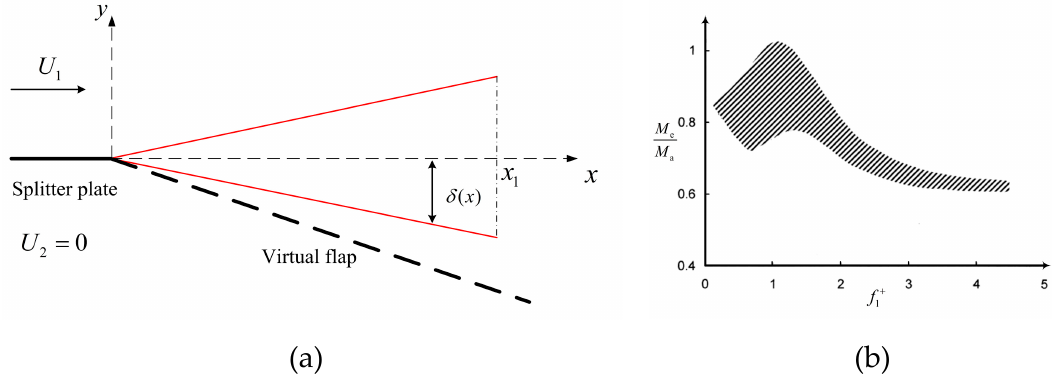
Figure 9. Entrainment ratio of free shear layer (referring to [1]): ( a ) Diagram of entrainment ratio; ( b ) curve of entrainment ratio.